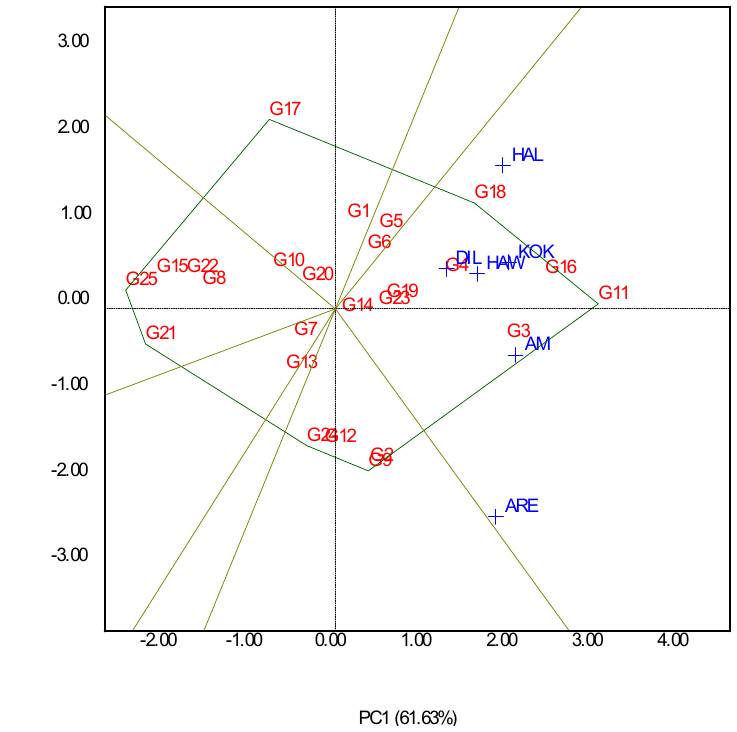
Figure 2: GGE-biplot showing environments and respective sweetpotato genotypes for RDMC